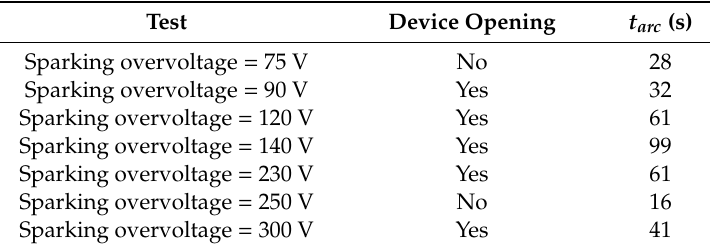
Table 4. Correct operation and intervention time with di ff erent surge arresters.